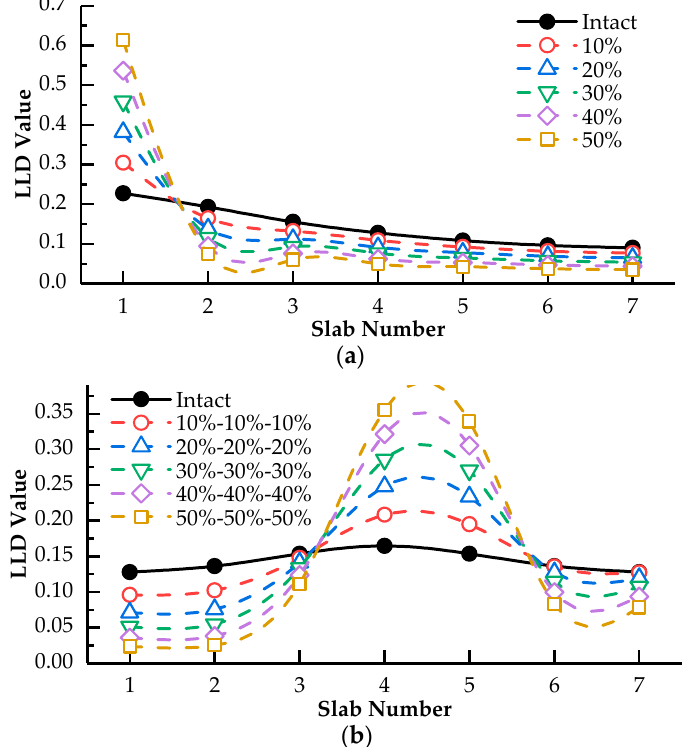
Figure 10. LLDs for a simply supported bridge with 7 slabs under different damage conditions: ( a ) LLD of slab 1 with hinge joint 1 damage; ( b ) LLD of slab 4 with hinge joints 2, 3, and 5 damages.